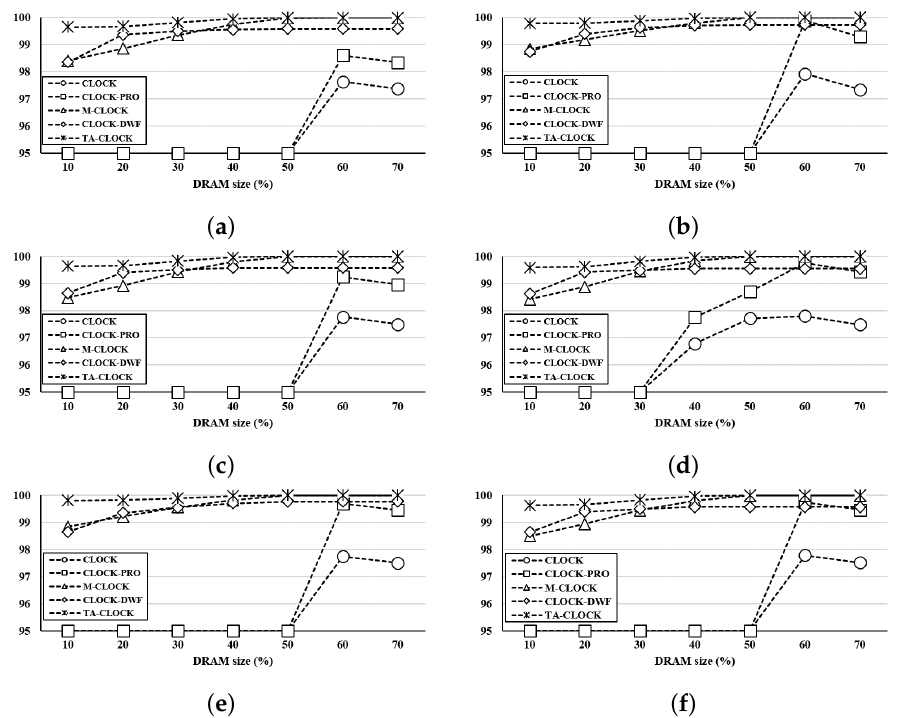
Figure 9. The hit ratio of write operations in DRAM (values of 95 or less are indicated as 95).